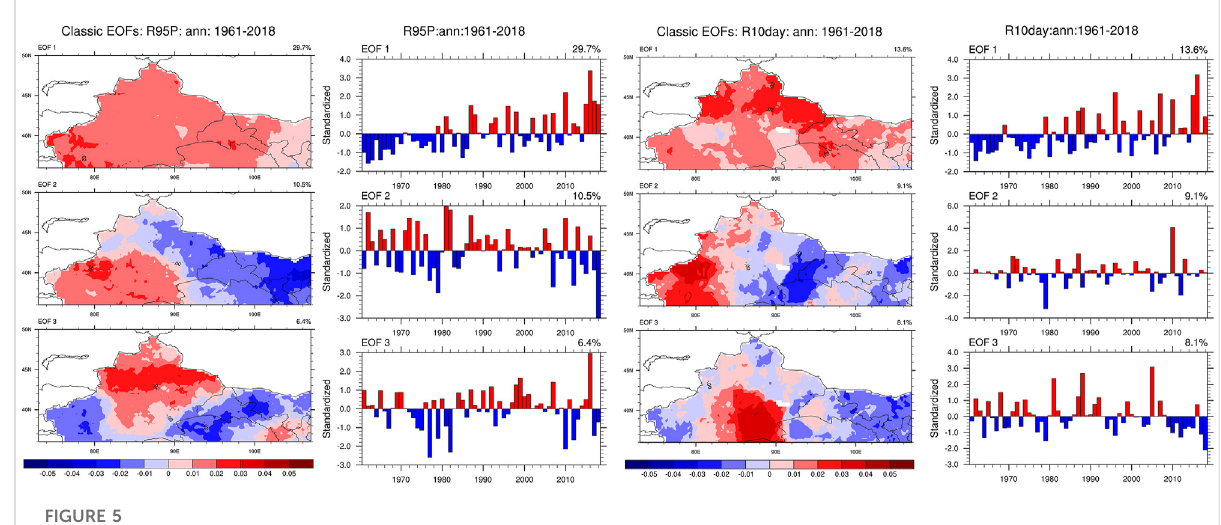
FIGURE 5 Spatial distributions of the fi rst three EOF modes of R95P and R10day in the ANWC during 1961 – 2018 and the corresponding standard time